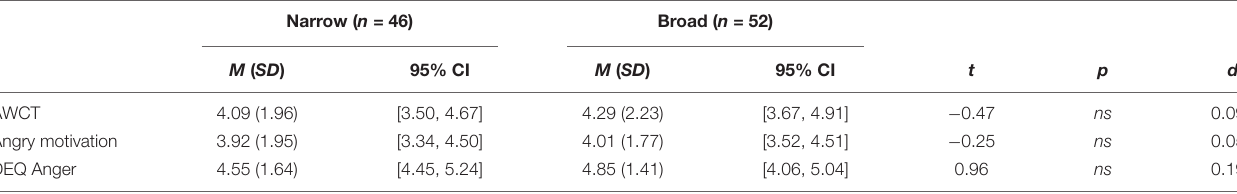
TABLE 6 | Effect of cognitive scope condition on angry word accessibility, angry motivation, and state anger – Study